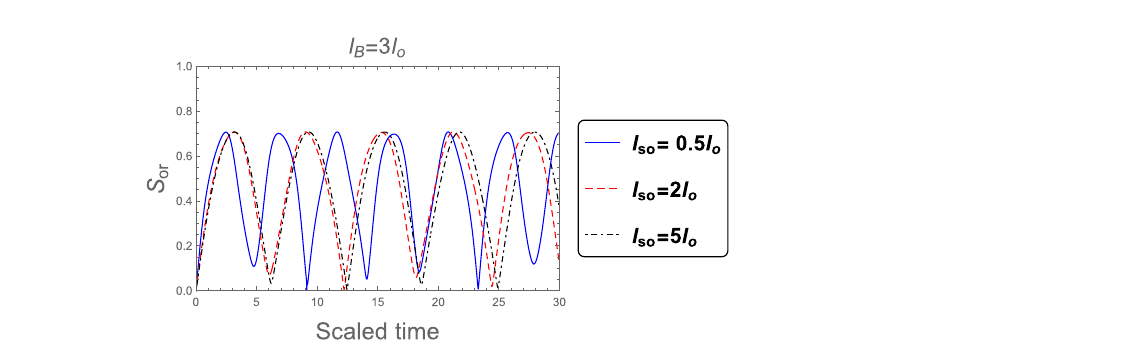
Figure 7. The orthogonality, S or , when the system’s initial state in the superposition state 1 ( ) , for distinct values of SOC strength l so �( 0 ) g, 0 g, 1 e, 0 e, 1 2 | � + | � + | � + | � | � = 0.5 l o is employed. the robust magnetic field l B =